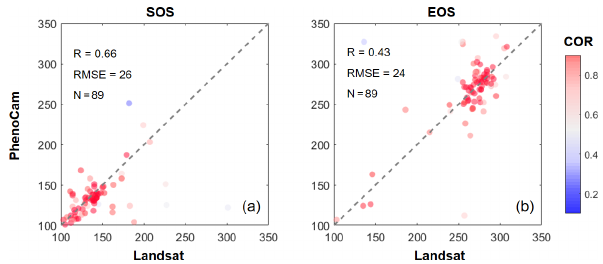
Figure 6. Comparison of the period (2001–2015) mean phenol- ogy indicators of the start of season (SOS) (a) and the end of sea- son (EOS) (b) derived from Landsat and PhenoCam observations. COR: the correlation coefficient between the raw and fitted EVIs using the double logistic